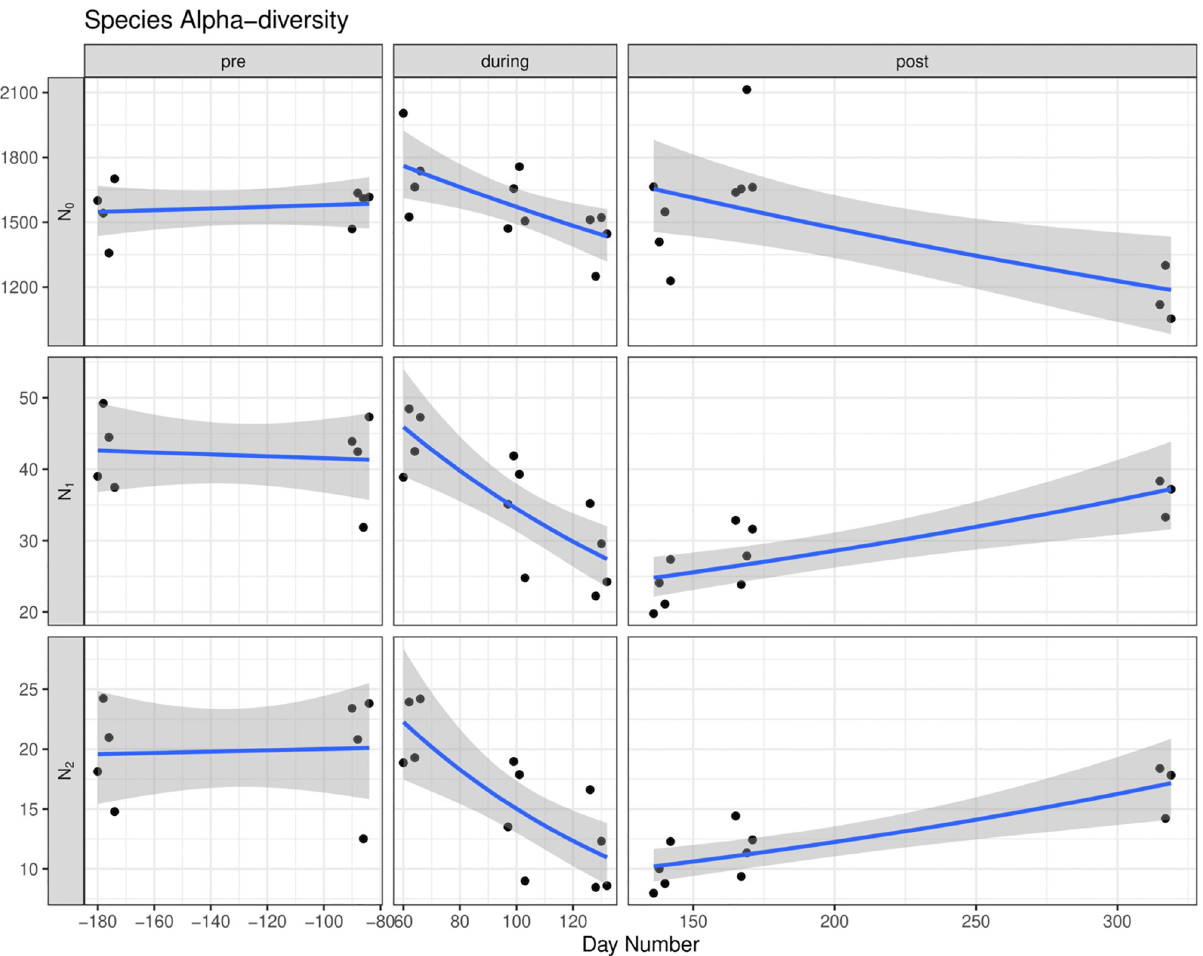
Fig 2. Alpha diversity for crewmember saliva samples at the species level resolution over time. Alpha diversity is quantified as Hill numbers corresponding to transformed richness (N 0 ), Shannon (N 1 ), and Simpson (N 2 ) diversity indices. Samples are shown as black points (round). A gamma regression line (blue) is fitted to the points with a 95% confidence interval in